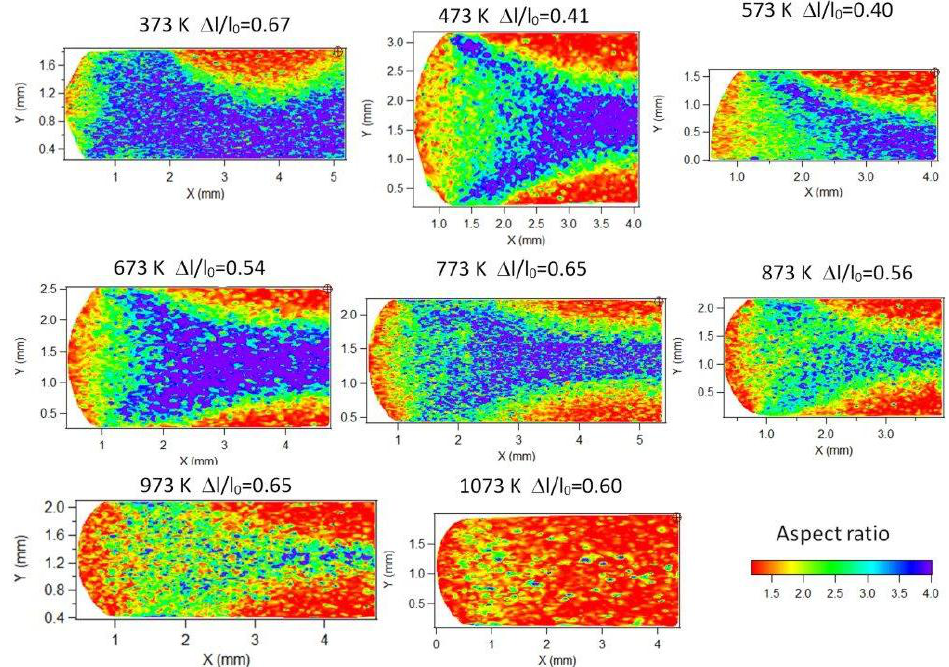
Figure 8. Nodule aspect ratio mapping of the DCI samples compressed at several temperatures, for plastic strain values ranging around 0.4 to